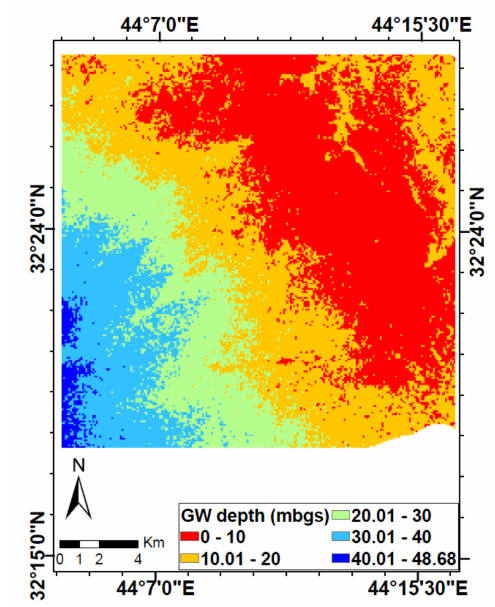
Figure 5. Groundwater table depth within Dibdibba study area (m.b.g.s.), modified after Al-Madhlom et al. (2019)